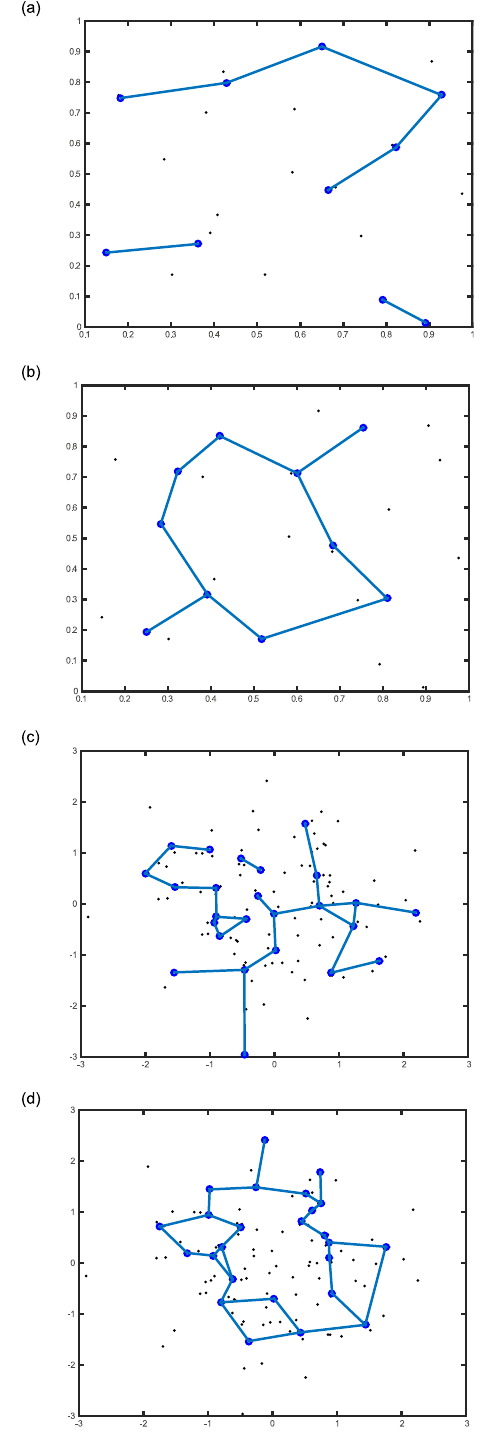
Fig 3. Comparison of TRN and ITRN. Black dots indicate the training patterns, and blue circles indicate codebook vectors. In the first experiment, 20 randomly generated training patterns (S1 Dataset) and 10 codebooks were selected, and (a) and (b) show the results generated by TRN and ITRN, respectively. In the second experiment, 100 randomly generated training patterns (S1 Dataset) and 25 codebooks were selected, and (c) and (d) show the results generated by TRN and ITRN,